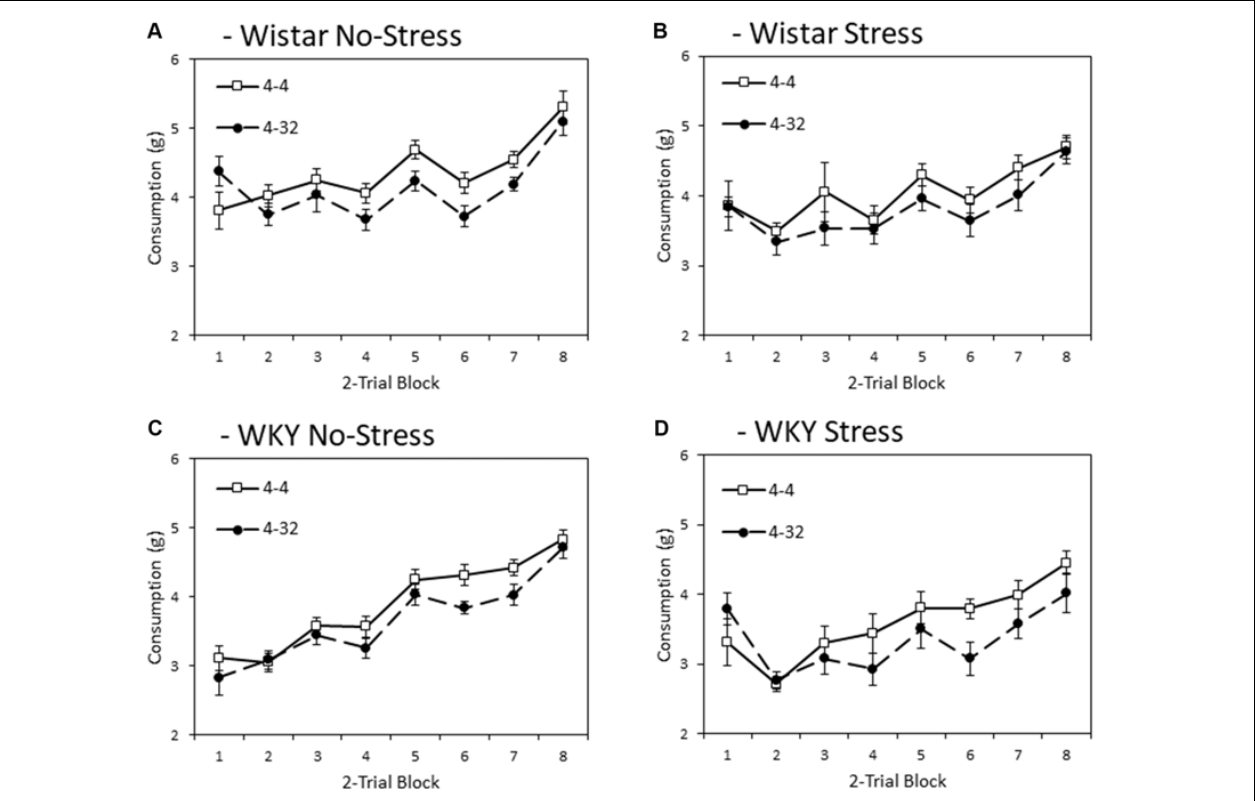
FIGURE 2 | Anticipatory contrast in mean consumption ( ± SEM) of the initially presented 4% sucrose solution as a function of whether it was followed by either 4% sucrose (open symbols) or 32% sucrose (filled symbols), separated by strain (Wistar: Panels A,B ; WKY: Panels C,D ) and stress groups (No-Stress: Panels A,C ; Stress: Panels B,D ). The data presented is averaged over two-day blocks. The solution was available for 3 min per day. WKY rats consumed significantly less than Wistar rats, and stressed rats consumed significantly less than no-stress rats, and these effects did not interact. Critically, there was an anticipatory contrast effect (consumption of 4% sucrose was significantly lower when followed by 32% sucrose than 4% sucrose) and this effect did not interact with strain or stress manipulations (see “First Solution Consumption—Anticipatory Contrast” section for details).